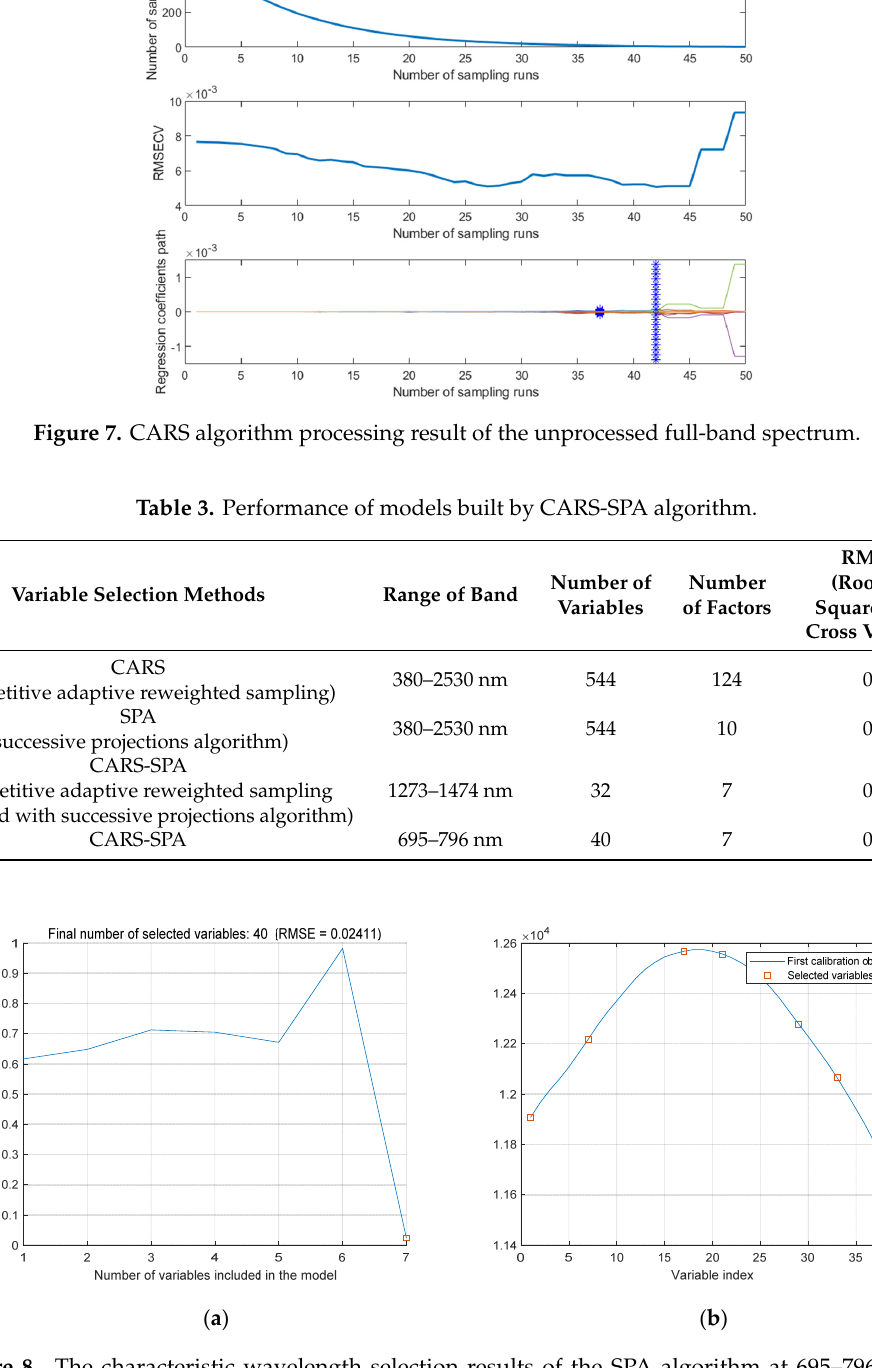
Table 4. Simple linear inversion model and the accuracy.